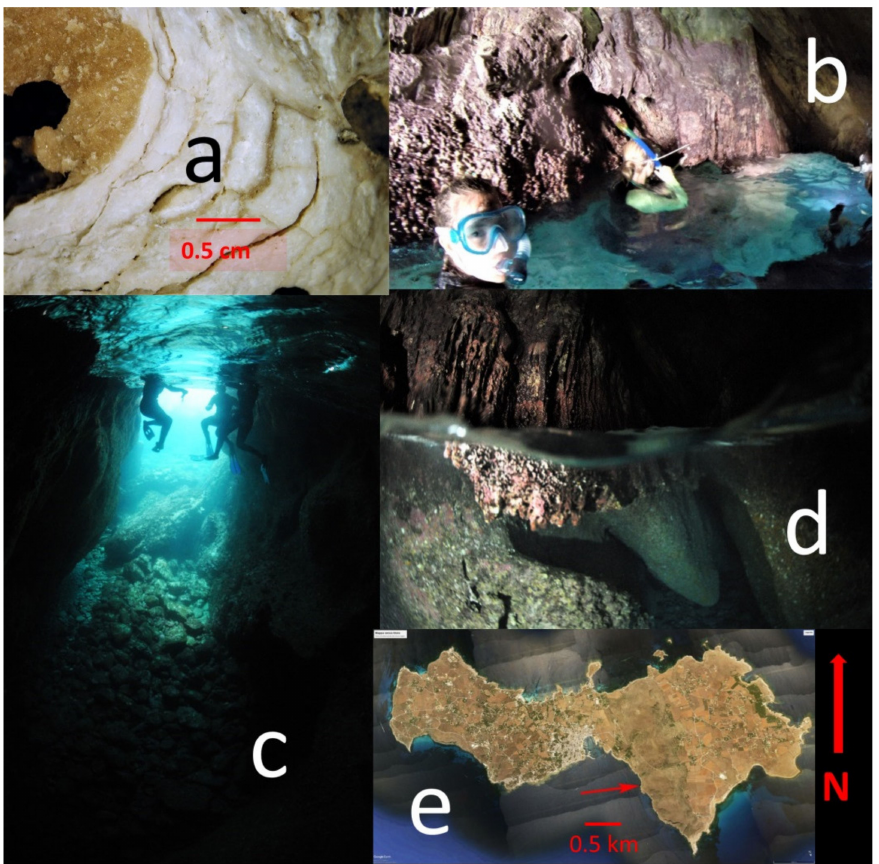
Figure 8. Coastal cave and submerged speleothems at Favignana Island, Italy (Figures 1 and 4; Tables 2 and 3). ( a ) Section of stalactite sampled at − 0.32 m with the continental portion (brown) and the phreatic portion (white). ( b ) Sampling survey at the bottom of the cave. ( c ) Photo of the cave. ( d ) The appearance of the freshly sampled stalactite. ( e ) Favignana and the site of the Stalattiti